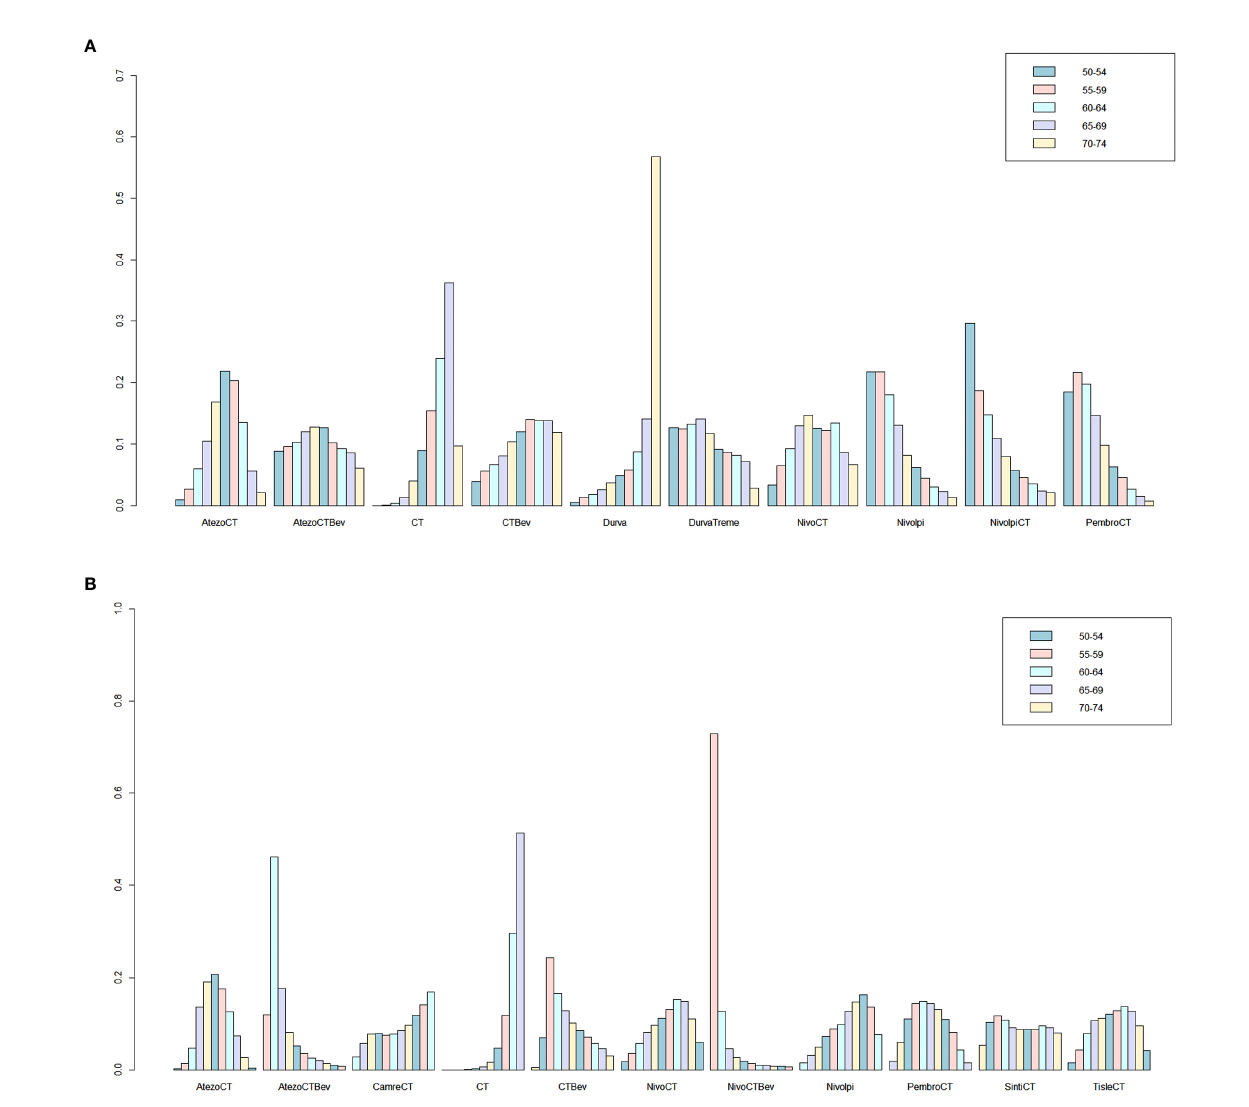
FIGURE 5 | Ranking probabilities based on the multiple comparisons on OS (A) and PFS (B) in NSCLC patients with PD-L1 – negative expression. CT, chemotherapy; Atezo, atezolizumab; Bev, bevacizumab; Nivo, nivolumab; Ipi, ipilimumab; Pembro, pembrolizumab; Carem, caremlizumab; Durva, durvalumab; Treme, tremelimumab; Tisle, tislezumab; Sinti, sintilimab; NR, not